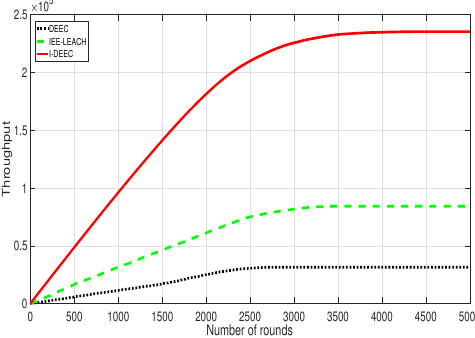
Figure 12. Comparison of data